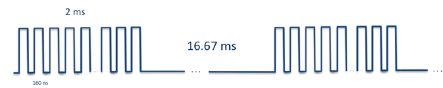
Figure 6. Time structure of the proposed Cornell extracted